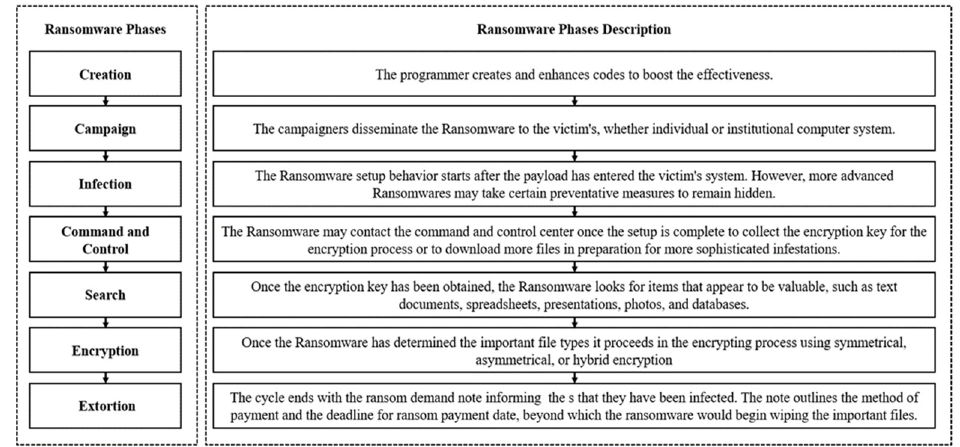
Figure 1. Ransomware lifecycle from creation to extortion.